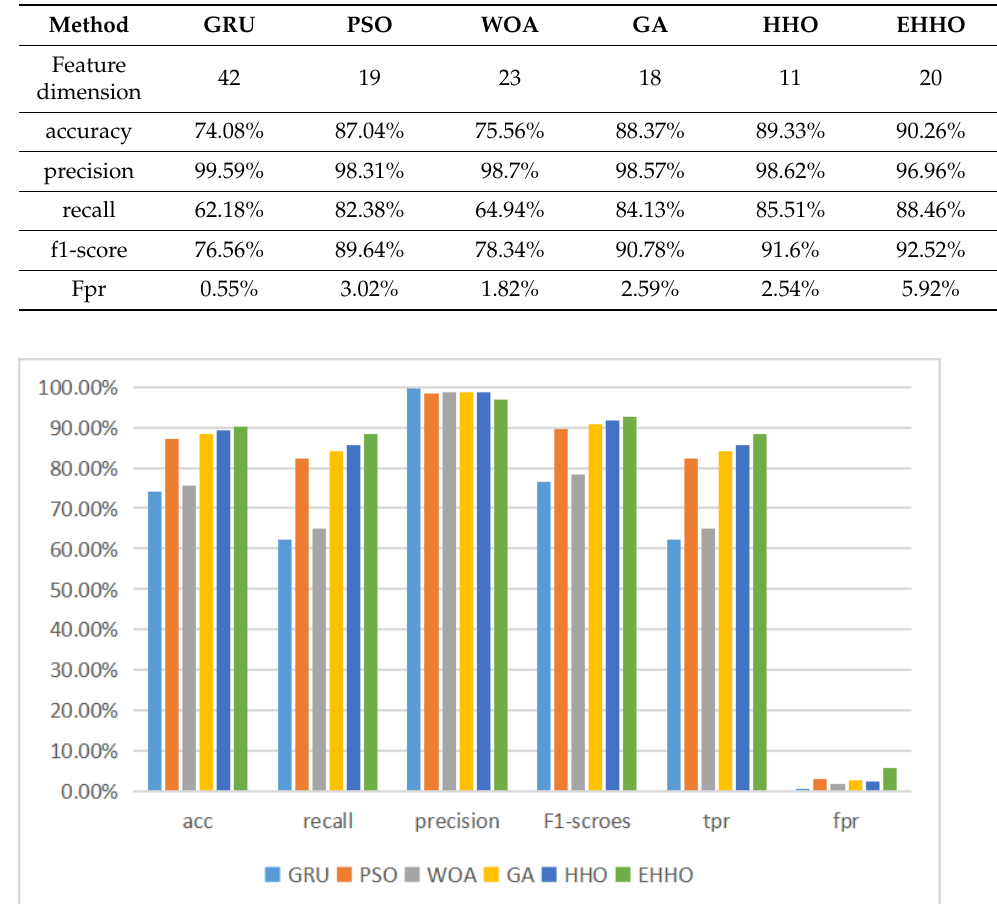
Figure 11. Binary classification histogram of